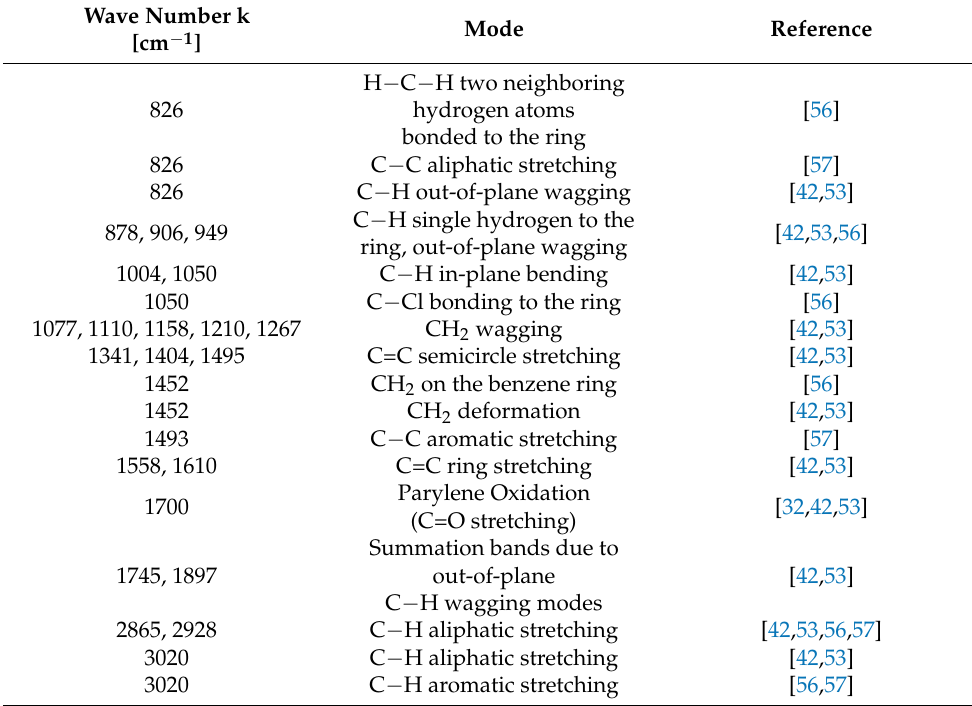
Table A1. Assignment of the FTIR vibrational